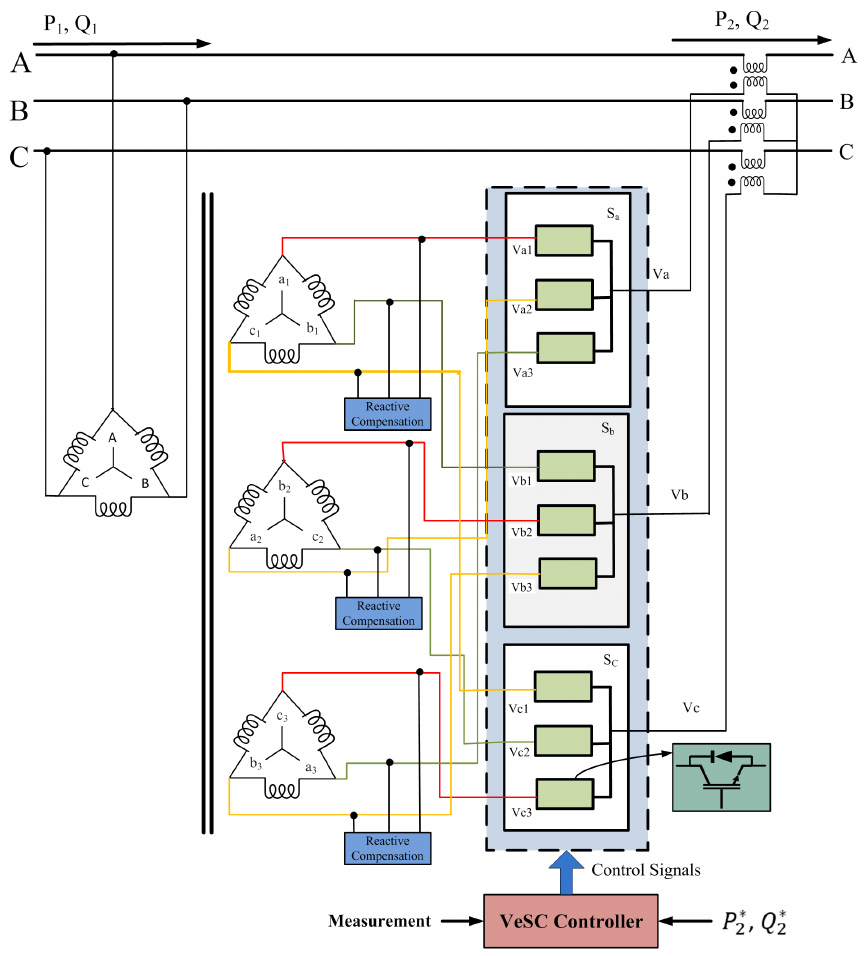
Figure 13. High Frequency AC Link using a vector switching converters